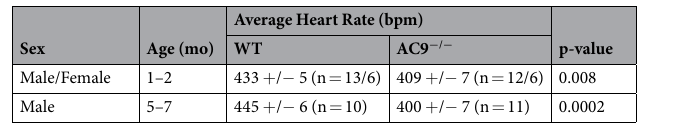
Table 1. Deletion of AC9 gives rise to